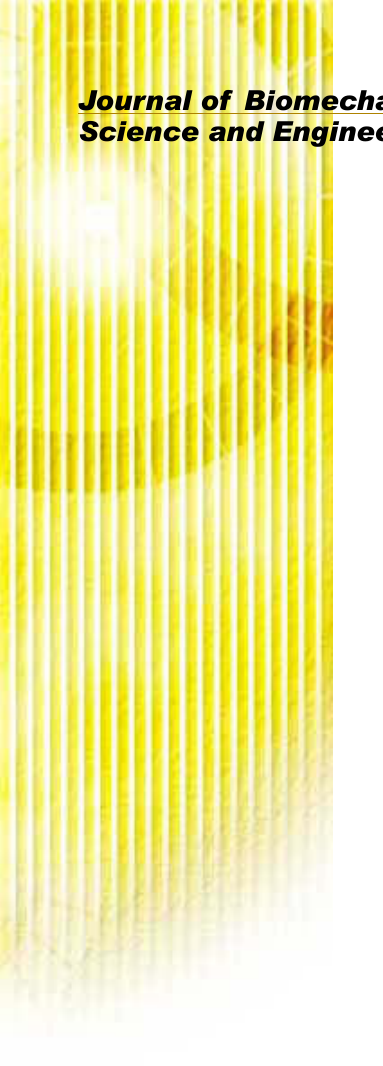
Hip flexion/extension angular position (in deg) during the gait cycle